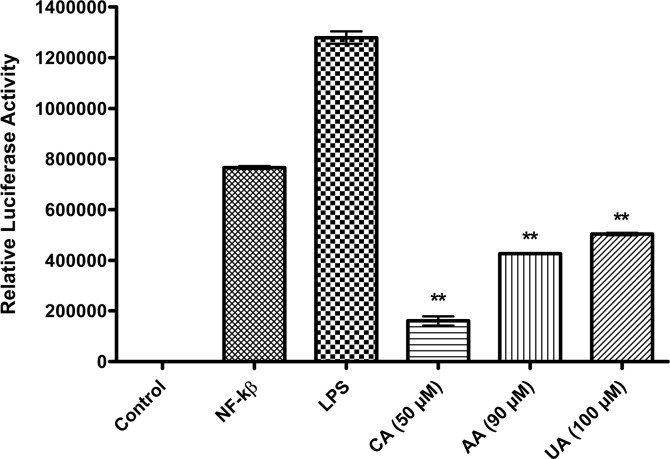
Effects of CA, AA and UA on LPS-induced NF-κB transcriptional activity.Cells were transiently co-transfected with pNF-κB-luc reporter and then either left untreated (Control) or were pre-treated with IC50 concentrations of CA (50 μM), AA (90 μM) and UA (100 μM) for 90 min. LPS (1 μg/ml) was added and cells were further incubated for 4 h, then harvested and luciferase activities were determined using a luciferase assay system and a luminometer. Bars show means ± SD (n = 3). *P (ANOVA) < 0.05 versus LPS only-treated group.